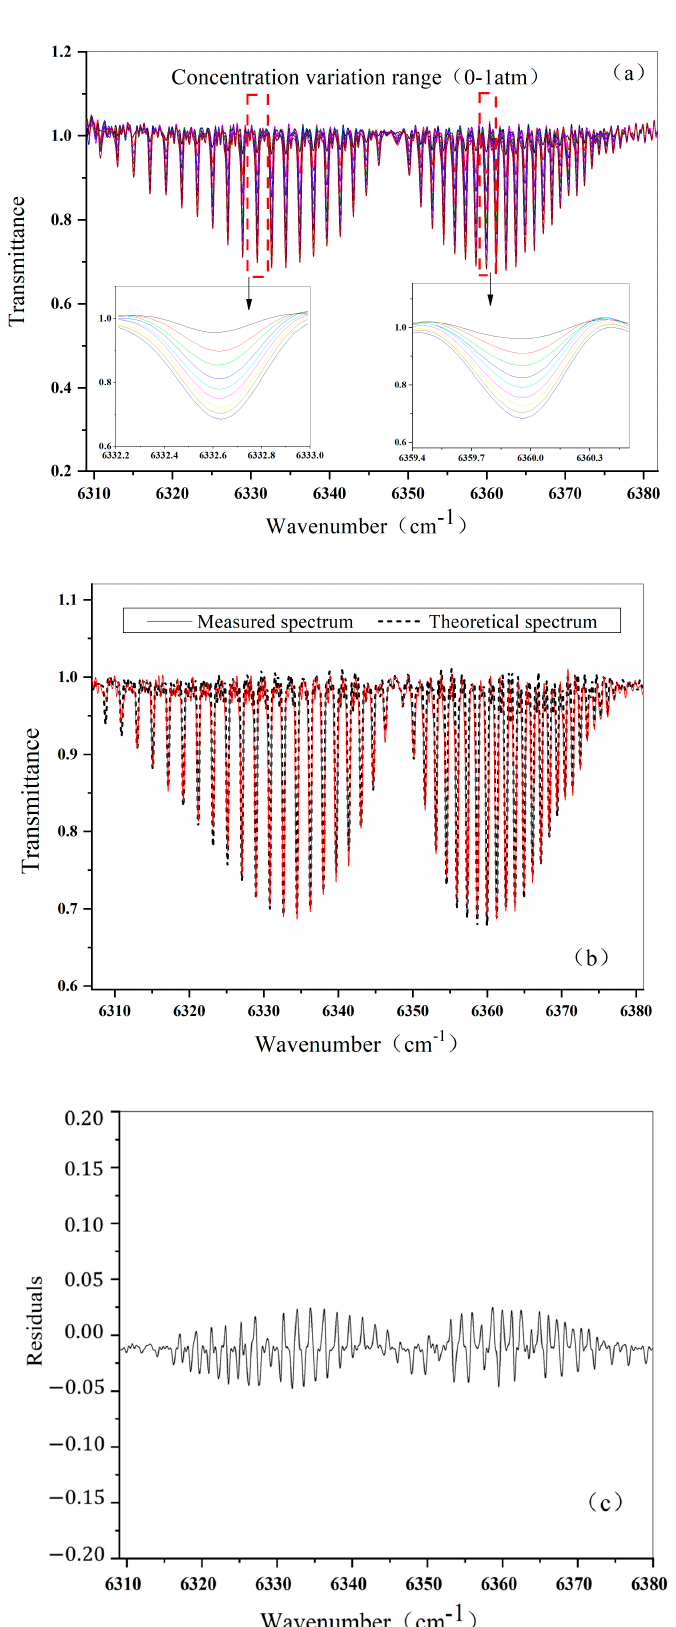
Figure 7. Test data of absorption spectral transmittance of CO 2 spectral channel. (( a ): absorption spec- tra at different gas distribution states, ( b ): theoretical spectrum and measured absorption spectrum, ( c ): difference between theoretical and measured absorption